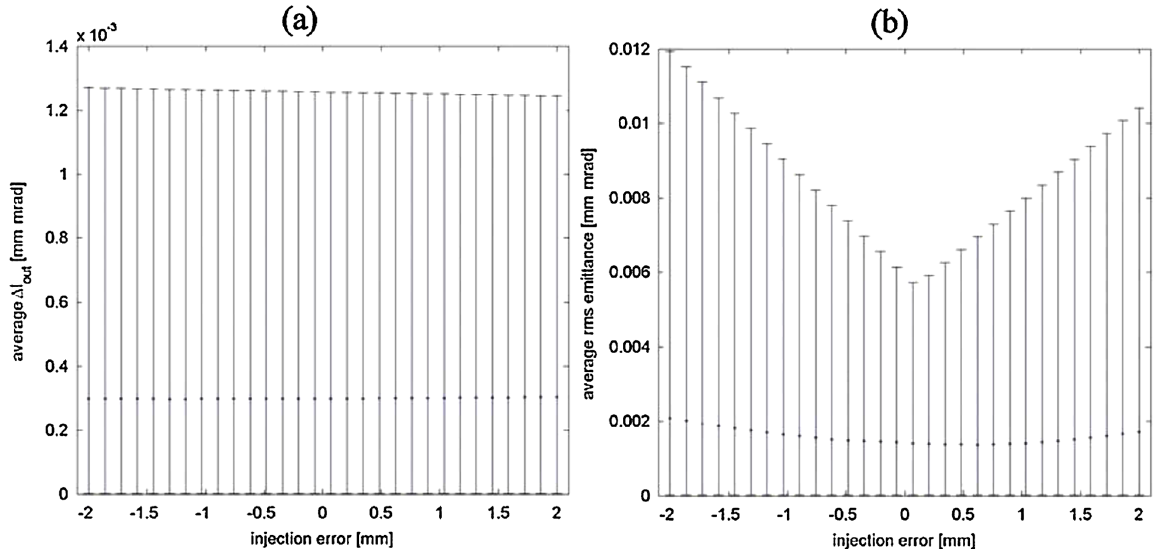
FIG. 19. (a) Average centroid invariants calculated with respect to the case of no wake in case of an orbit error at injection. The bars indicate the maximum deviation from the mean value calculated over the train. (b) Average rms emittances in case of an orbit error at injection. The bars indicate the maximum deviation from the mean value calculated over the train.